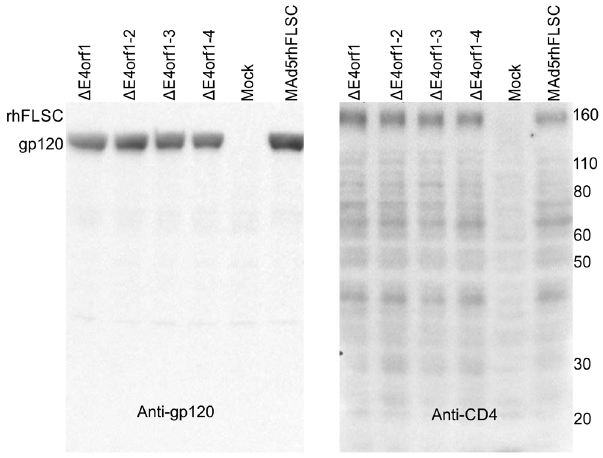
Figure 5. Deletion of E4orf1 through E4orf4 has no effect on transgene expression. HeLa cells were plated and the day after infected at an MOI of 50 PFU/cell with the indicated viruses. 48 hours post infection the cells were lysed directly in boiling 1X protein sample buffer and the total cell lysates were analyzed by western blot using either anti-gp120 or anti-CD4 to identify the rhFLSC protein. The figures shown are representative of 2–4 experiments.